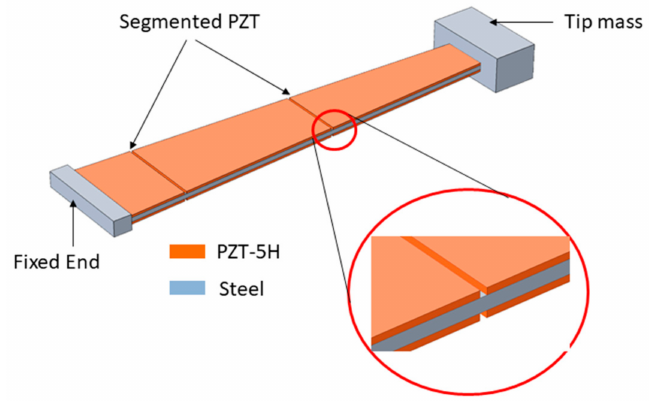
Figure 1. Segmented trapezoidal PEH.